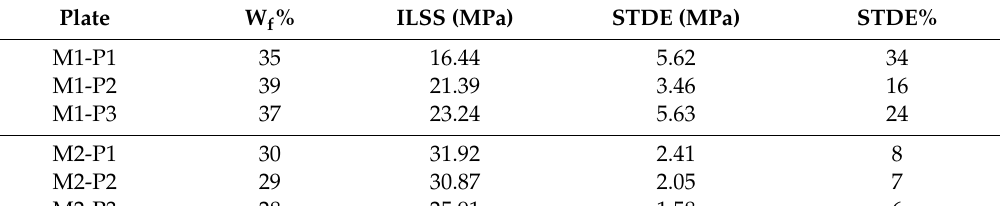
Table 6. Average ILSS of each individual plate from both sets.